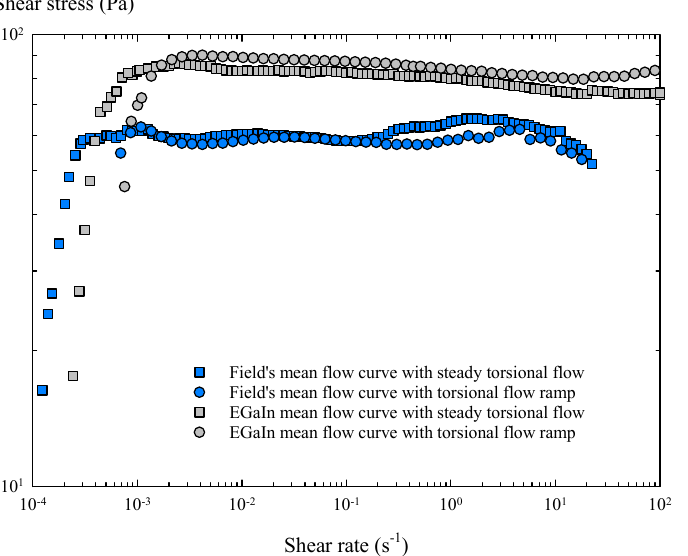
Figure 11. Averaged flow curves of Field’s metal and EGaIn obtained in steady torsional flow and torsional flow ramp